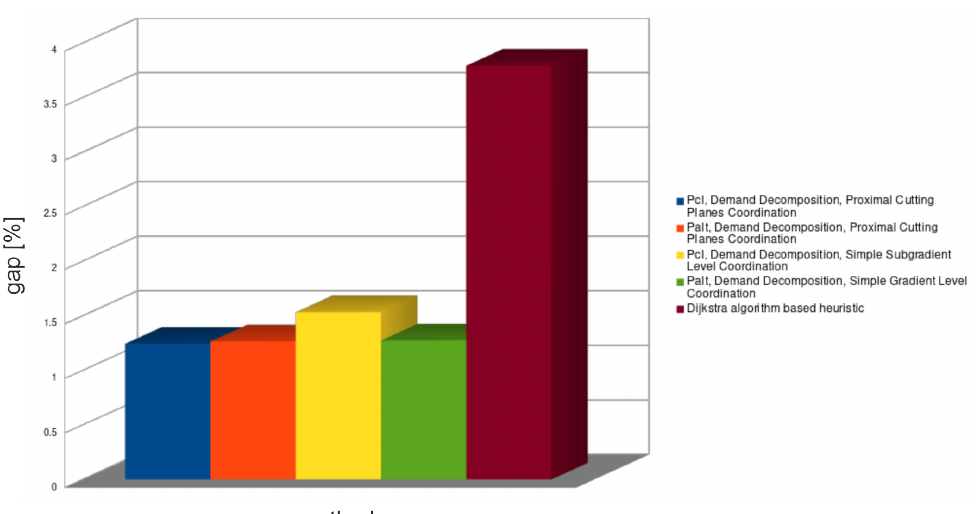
Figure 9. Average upper bound relative gap for all decomposition methods—large problems.